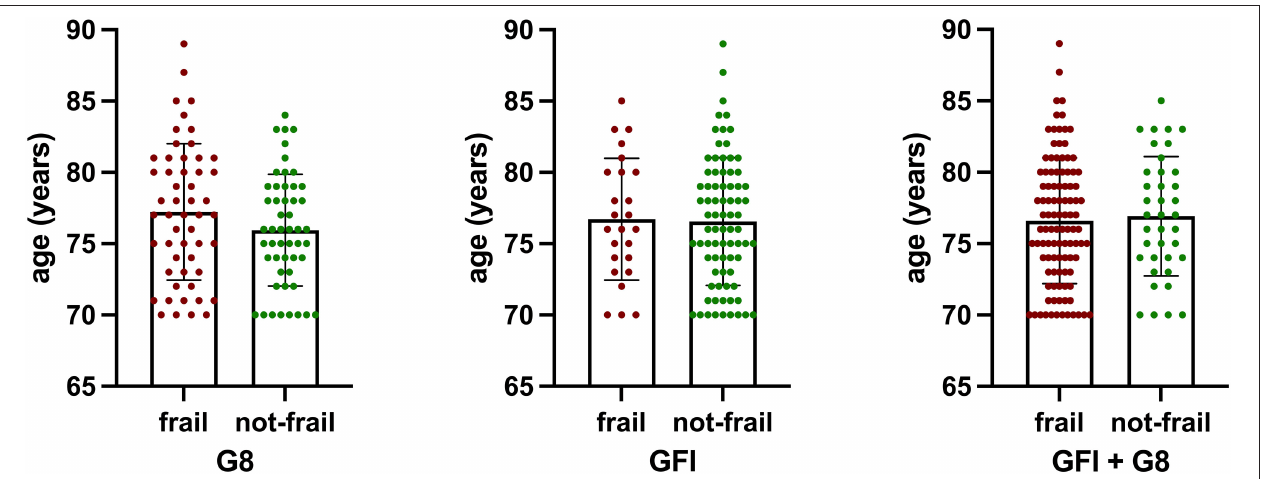
Entire cohort ( n = 104)